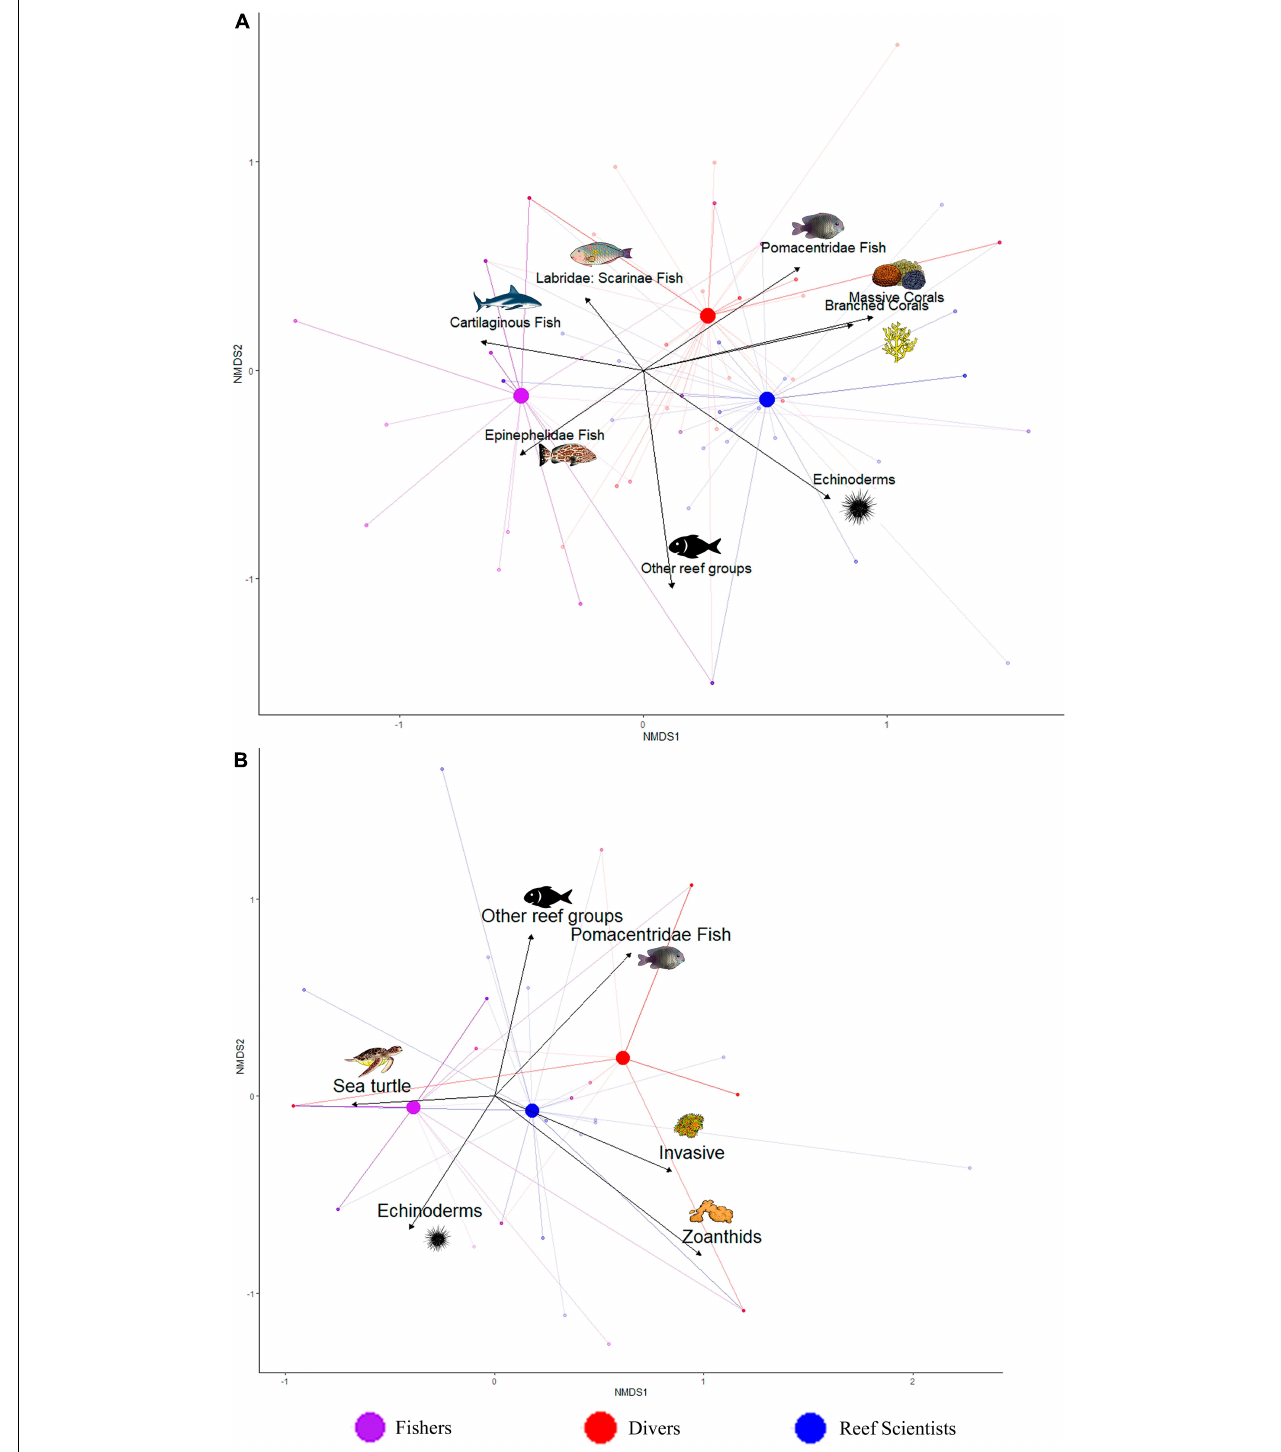
FIGURE 4 | Non-metric multidimensional scaling (NMDS) for organisms that have change in reef landscapes comparing the perception of the three types of stakeholders in the study: fishers, divers, and reef scientists. (A) Organisms that have declined (“stress value” = 0.12). (B) Organisms that have increased (“stress value” = 0.07). The stakeholders are represented through the colorful vectors, purple for fishers, red for divers, and blue for reef scientists. The black vectors represented the trend data for three types of stakeholders.